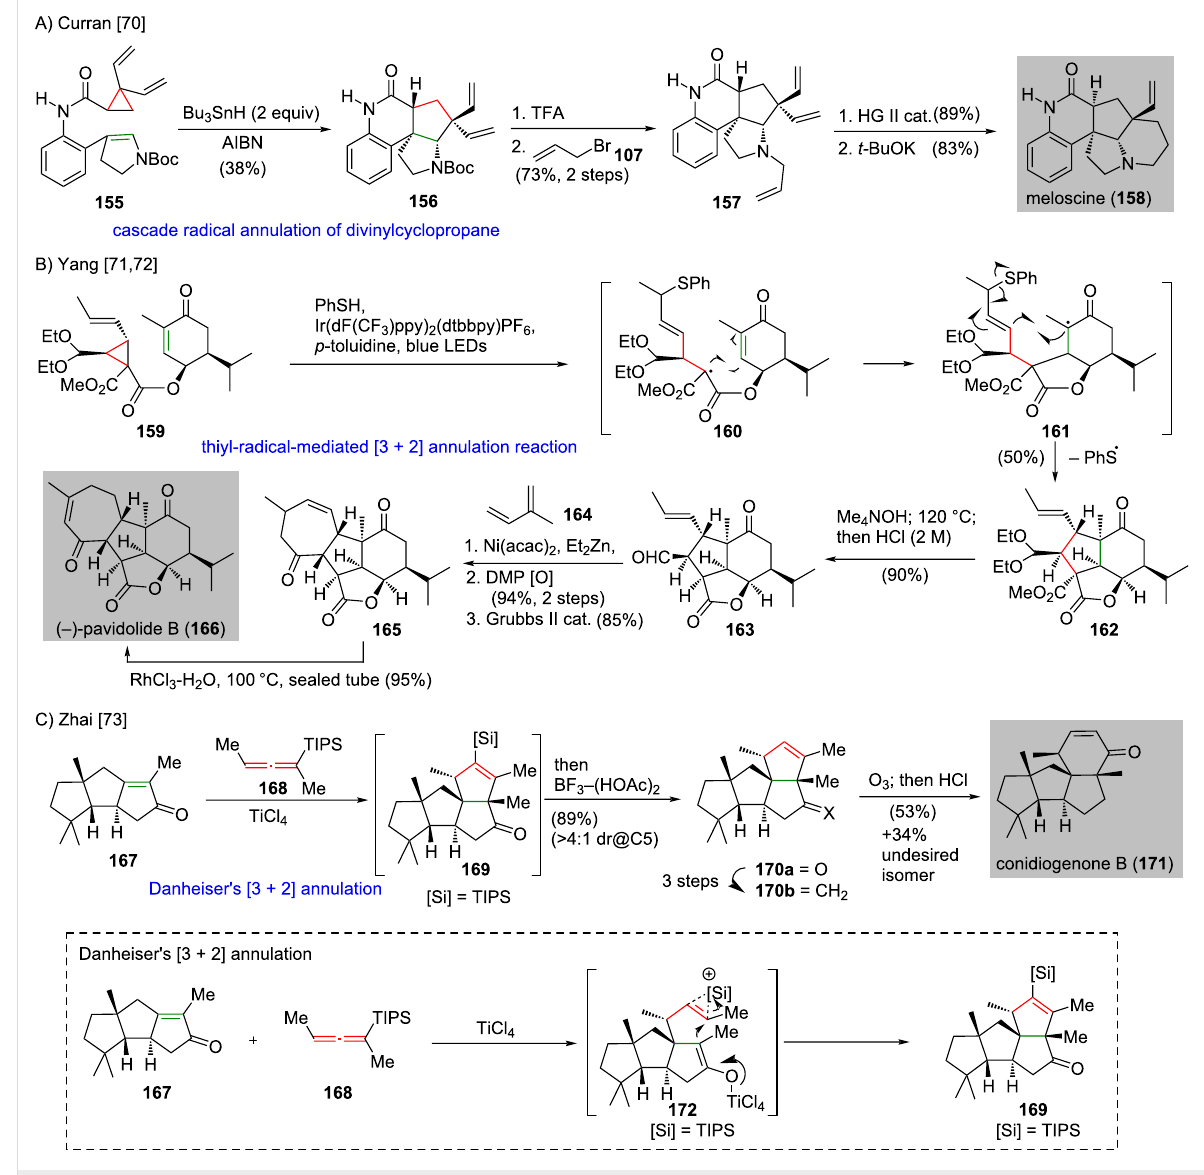
Scheme 13: The recent advances of [3 + 2] annulation in natural product synthesis. (A) The preparation of meloscine ( 158 ) features a cascade radical annulation of divinylcyclopropane [70]. (B) Thiyl-radical-mediated [3 + 2] annulation reaction realizes the synthesis of ( − )-pavidolide B ( 166 ) [71,72]. (C) A Danheiser’s [3 + 2] annulation en route to conidiogenone B ( 171 ) [73] (inset, the suggested mechanism based on Danheiser’s proposal disclosed in 1981